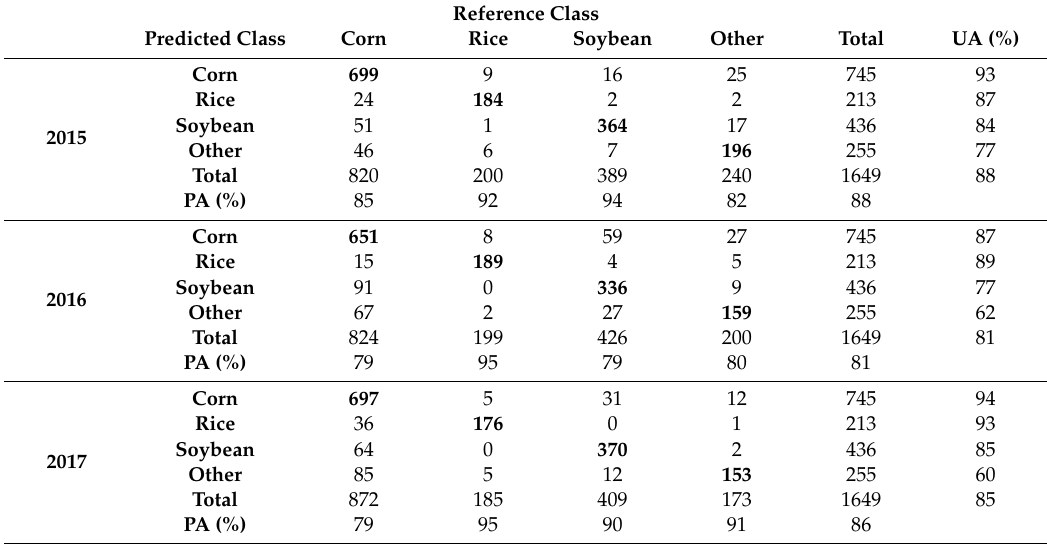
Table 6. Confusion matrix of the three-year classification results, the user accuracy and producer accuracy of various crops, the overall classification accuracy, and the average classification